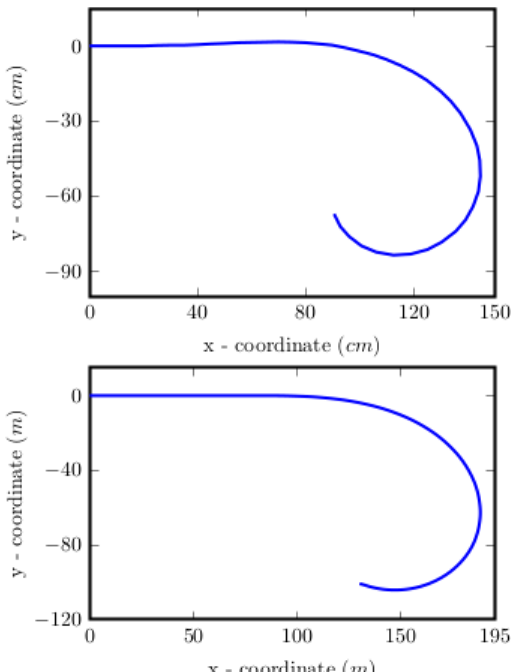
Figure 12. The path traced by the vehicle for the no transition example. Top: Lego model; Bottom: Blender model.